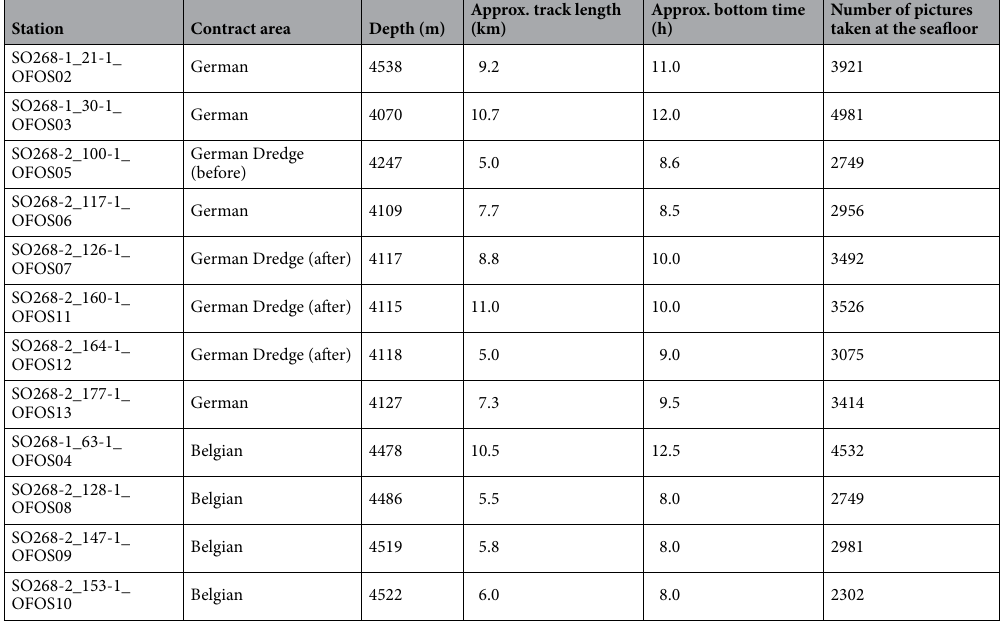
Table 1. Overview of the OFOS deployments in the Clarion Clipperton Zone during cruise